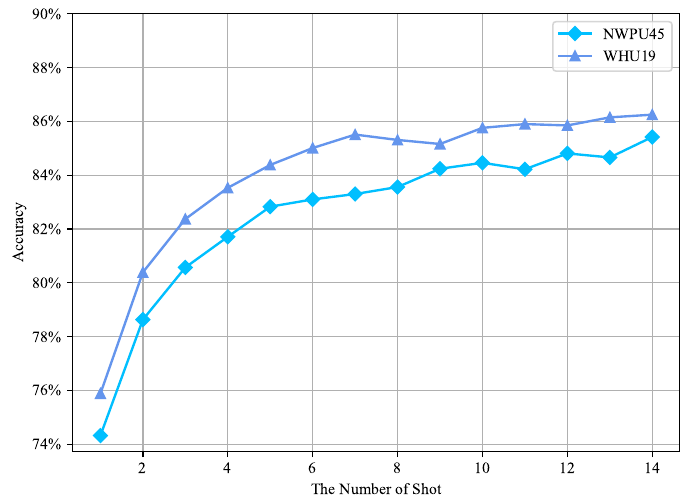
Figure 10. Accuracy with different numbers of shot on two